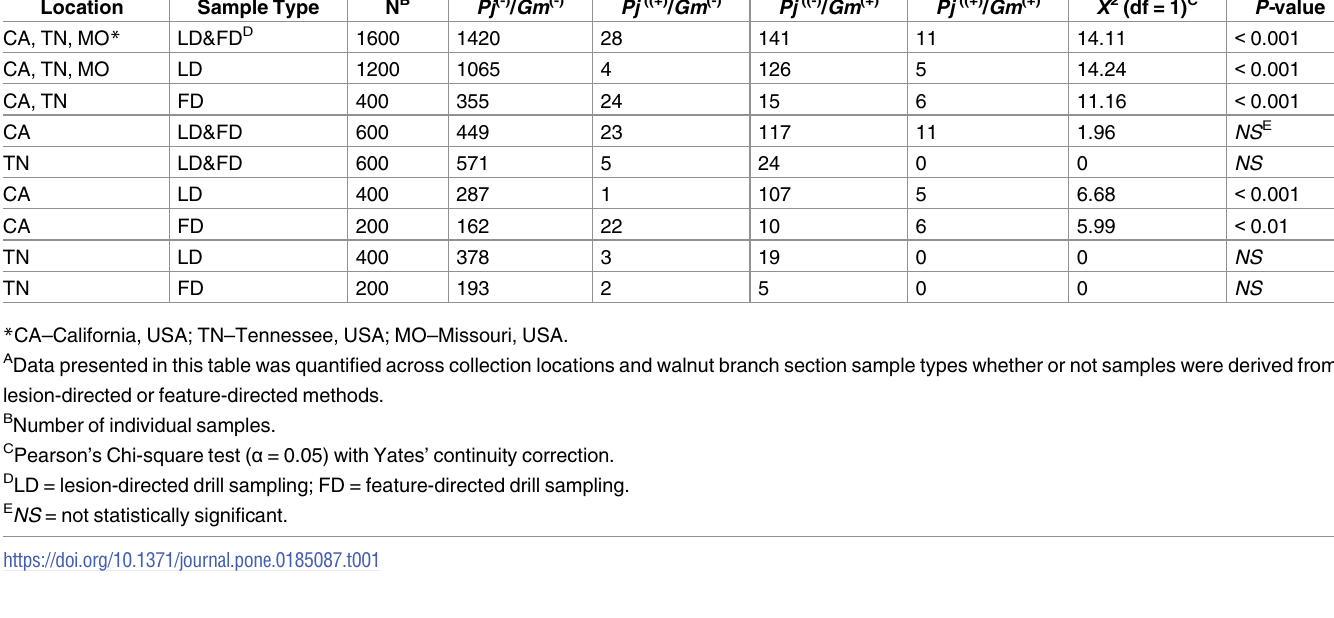
Table 1. Comparisons of molecular detection of Geosmithia morbida ( Gm ) and Pityophthorus juglandis ( Pj ) among drill cores taken from three locations, including sites (CA, TN) where the organisms are known to occur A .